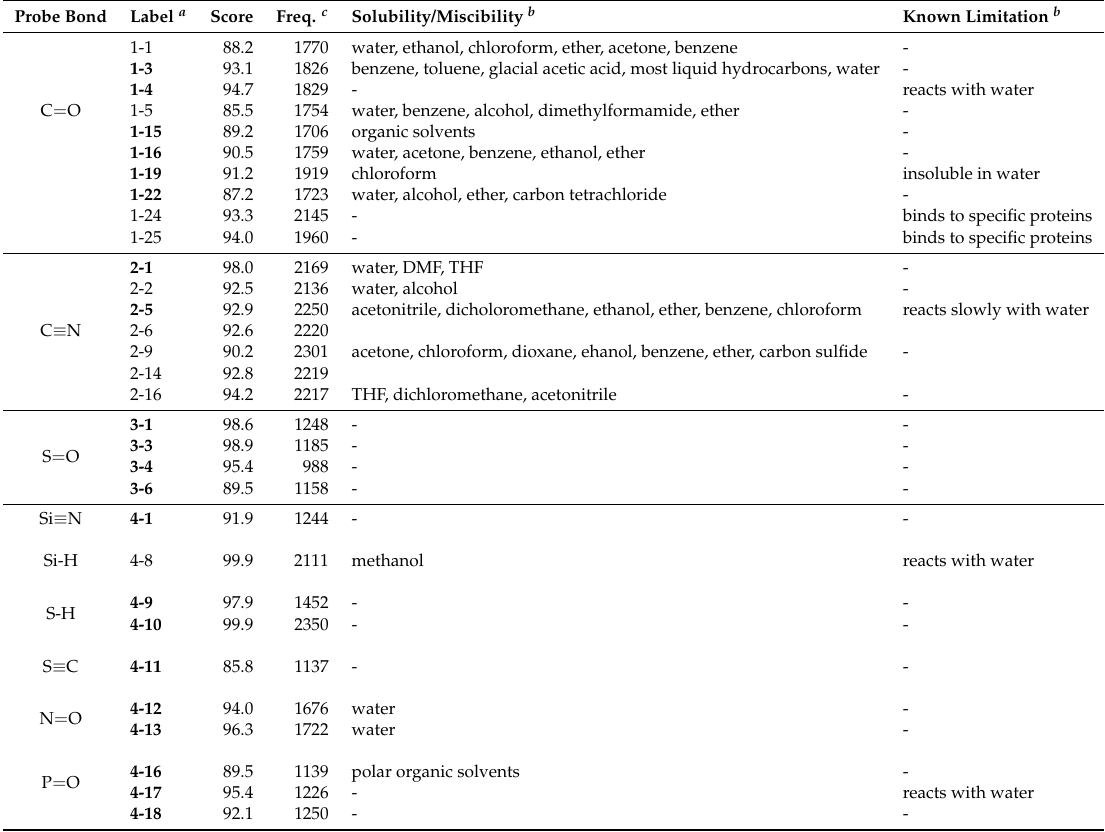
Table 3. Summary of ideal vibrational Stark effect probes with their physicochemical